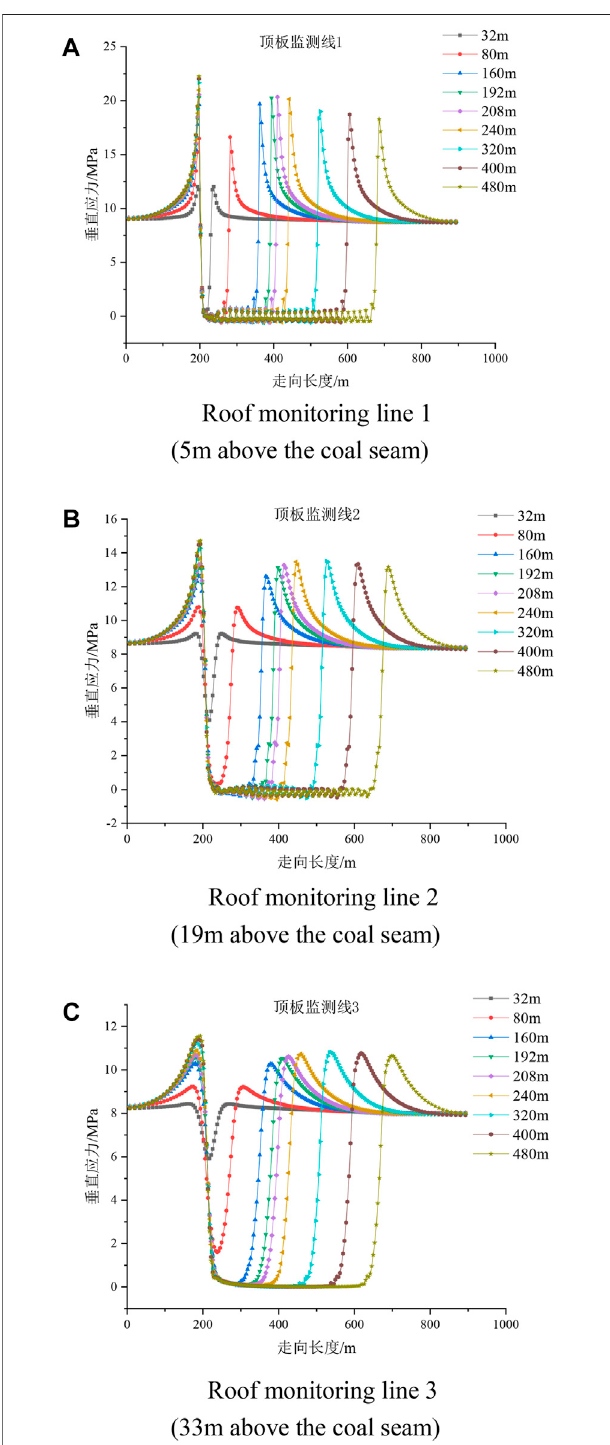
FIGURE 11 | Variation of vertical stress curve during working face advancement. (A) Roof monitoring line 1 (5m above the coal seam); (B) Roof monitoringline2 (19 m above the coal seam); (C) Roof monitoringline 3 (33 m above the coal seam).